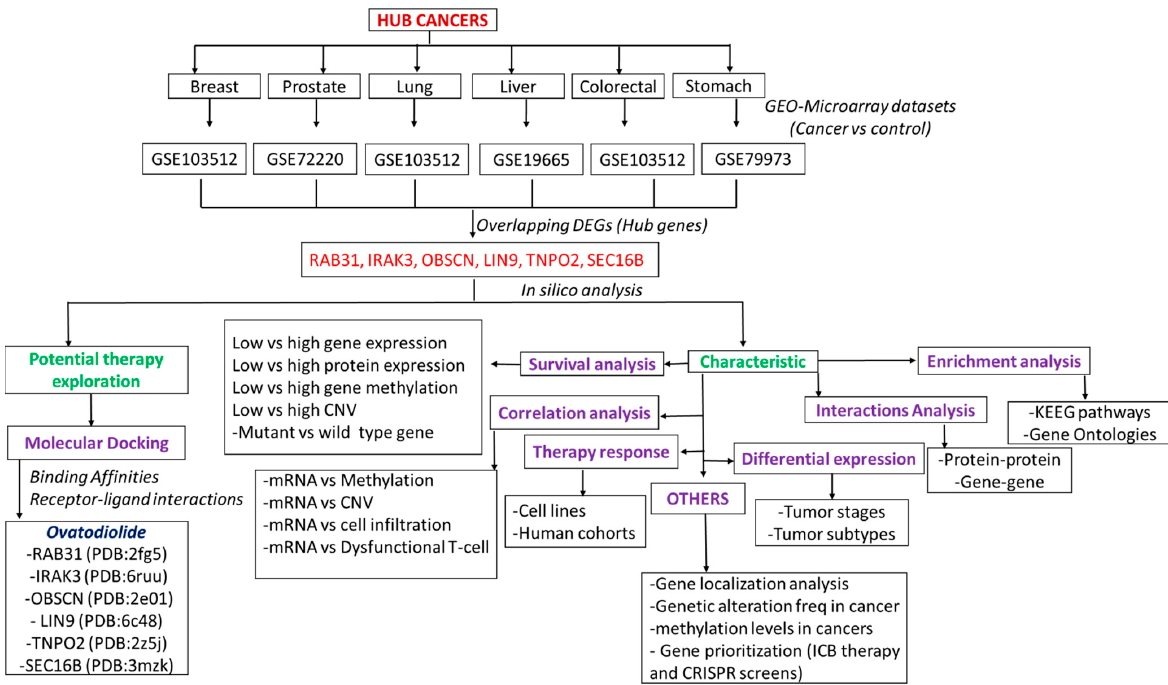
Figure 1. The flow chart of the study design for identifying the key DEGs in the pathology of the six cancers and predicting their potential druggability for ovatodiolide. Table 1. Characteristics of datasets used for the identification of the differentially expressed genes (DEGs). Cancers